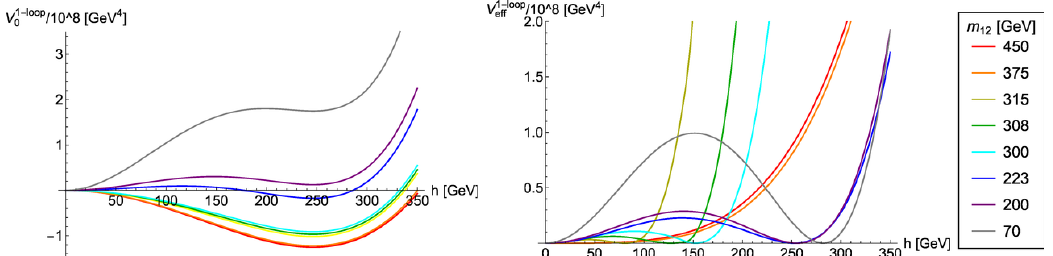
Figure 8 . The 1-loop potential curve at zero temperature (left) and (cid:12)nite temperature e(cid:11)ective potential evaluated at the critical temperature (right) for tan (cid:12) = 1 and various values of m 12 given in the legend. As (cid:12)gure 7, the mass of three BSM Higgs states are commonly (cid:12)xed at 600 GeV and sin( (cid:12) (cid:0) (cid:11) ) = 1 is